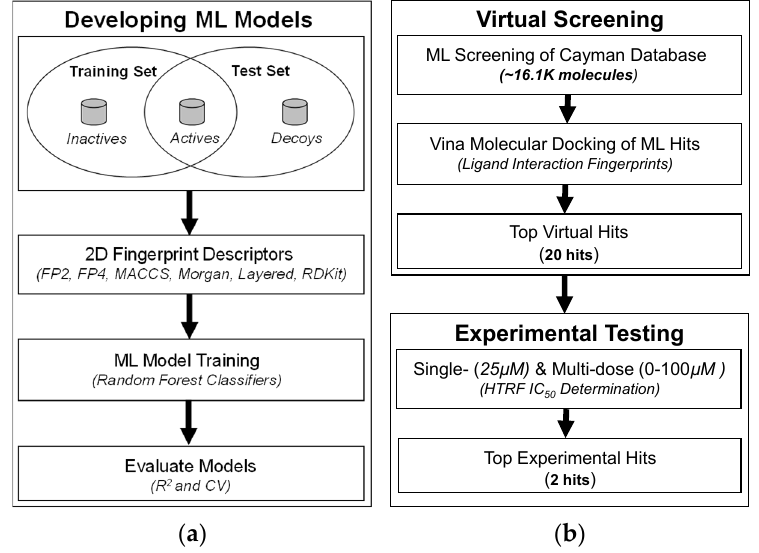
Figure 1. Overview of the integrated screening protocol to identify small-molecule inhibitors of PD1-PDL1 interaction: ( a ) Development of ML models based on 2D fingerprint descriptors of known ACTIVE and INACTIVE molecules against PDL1; ( b ) ML-based virtual screening, followed by experimental testing of top virtual hits using HTRF assay.